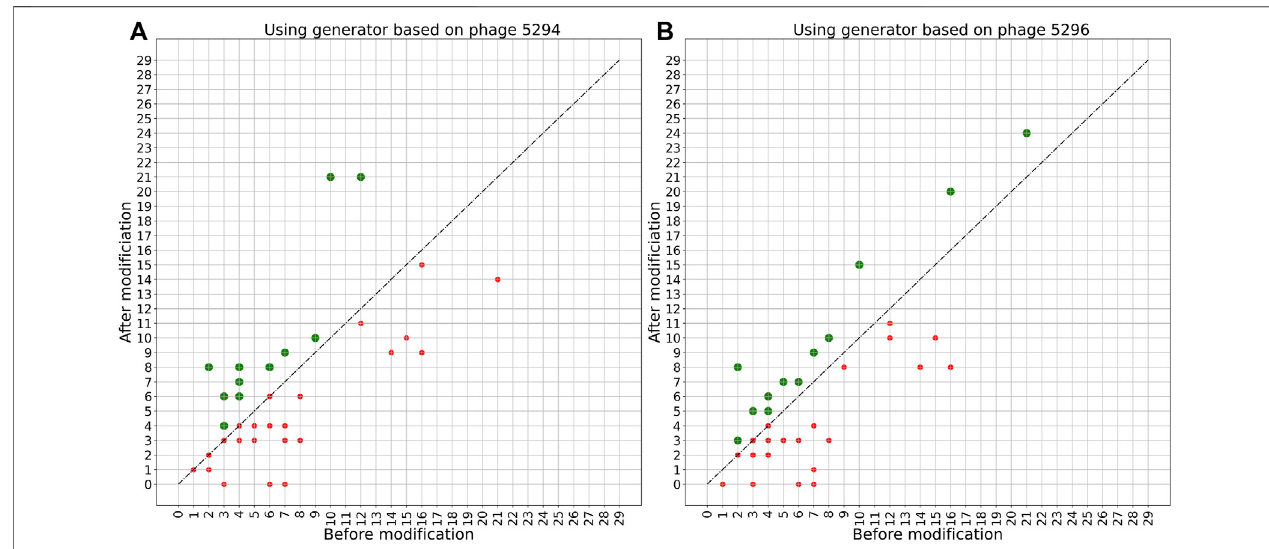
FIGURE7| ImpactofapplyingmodelAwitha200-nucleotideseedonphagesequences.Twomodelsaretrainedbasedonthegenomesequenceofeitherphage 5294 (A) orphage5296 (B) withaseedlengthof200.Thesetrainedmodelsarethenusedtomodifythegenomesequenceofall42phagesunderstudy.Theplotsshow the host range ofthese phages before and after modi fi cation using each trained model. The green spots show phages whose host range is improved after modi fi cation. The host ranges of 13 phages are improved after modifying with these two models.